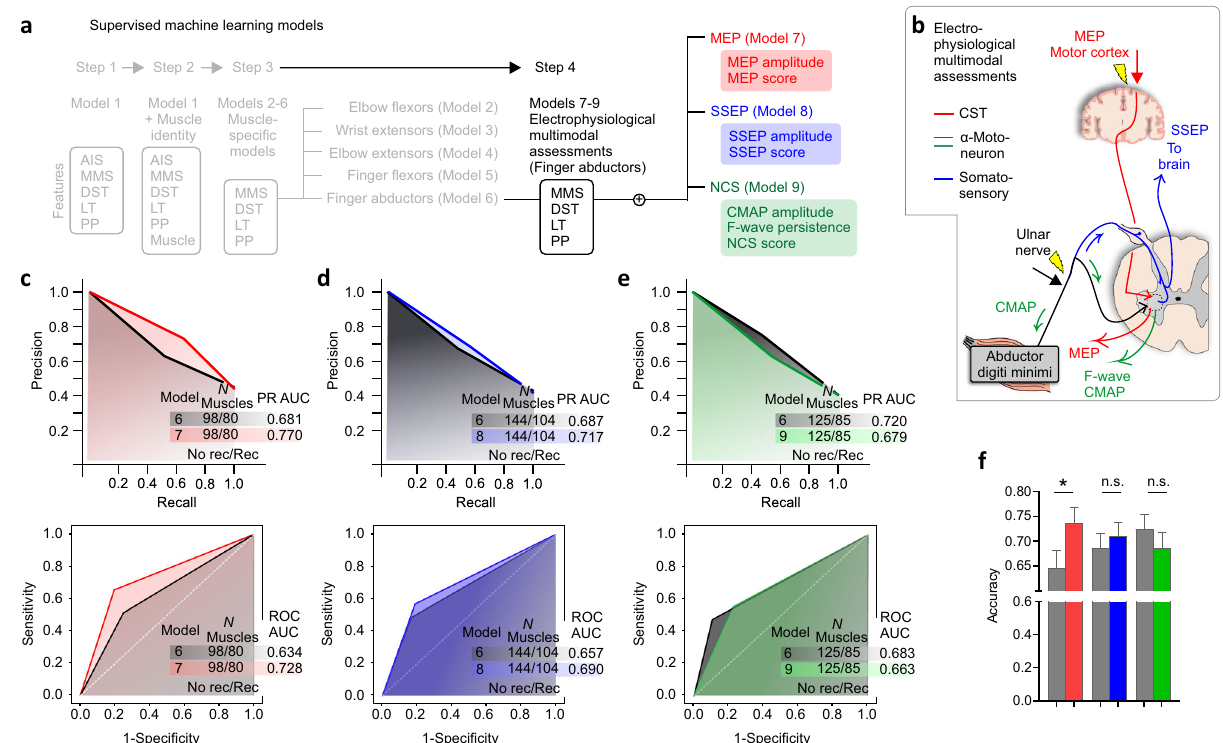
Fig. 6 | Prediction of strength recovery after cervical SCI: measures of spinal cord function(CSTand LMN) integrityincreasetheclassi fi cation performance of strength recovery of distal hand muscles in individuals with an AIS A/B/C. a Supervised machine learning models: a fourth step is utilized to understand the predictive factors for strength recovery in fi nger abductor muscles in AIS A/B/C. b ElectrophysiologicalmultimodalassessmentsofMEP,SSEP,andNCSofthedistal muscles of the upper limb ( fi nger abductors: abductor digiti minimi ). MEP ampli- tudeand latencyatthe abductor digit minimi muscle wasusedto quantify the CST andLMNintegrity(redline).SSEPwasmeasuredoverthescalpafterstimulationof the ulnar nerve using needle electrodes (blue lines). Ulnar nerve stimulation was also used during the NCS to measure F-waves and CMAP at the abductor digit minimi (green line). c – e PR and ROC curves indicate that the overall classi fi cation performance assessed by the AUC is increased for the MEP and SSEP subgroups. The most important electrophysiological features are MEP amplitude, SSEP